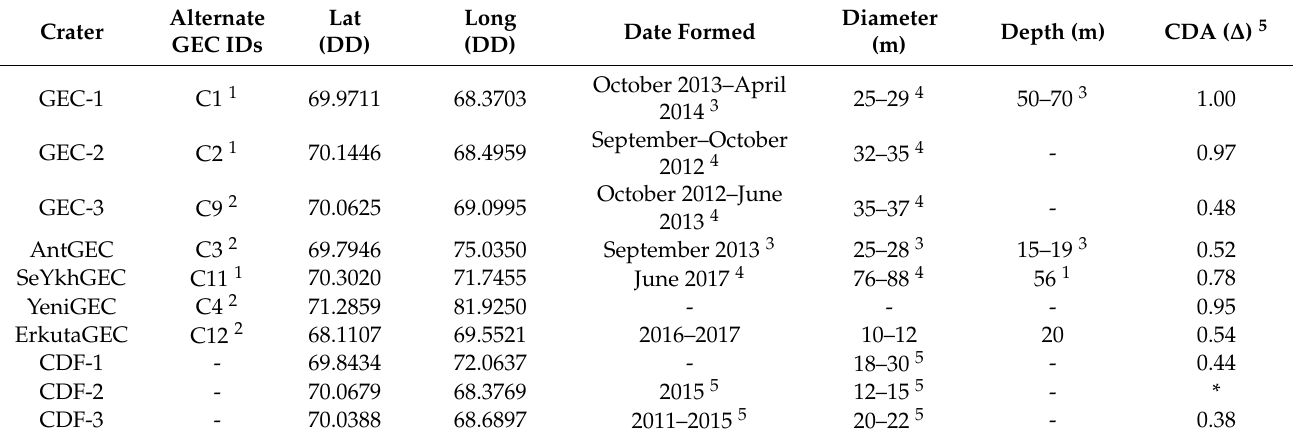
Table 2. Characteristics of gas emission craters (GECs) on the Yamal and Gydan peninsulas. CDF = change detection feature. Latitude (Lat) and longitude (Long) are reported in decimal degrees. ∆ = surface change value derived from the change detection algorithm (CDA). Approximate formation dates reported as month, when known, or a range of months/years. * No change pixels in area due to omission by water mask. 1 [24], 2 [25], 3 [17], 4 [16], 5 This